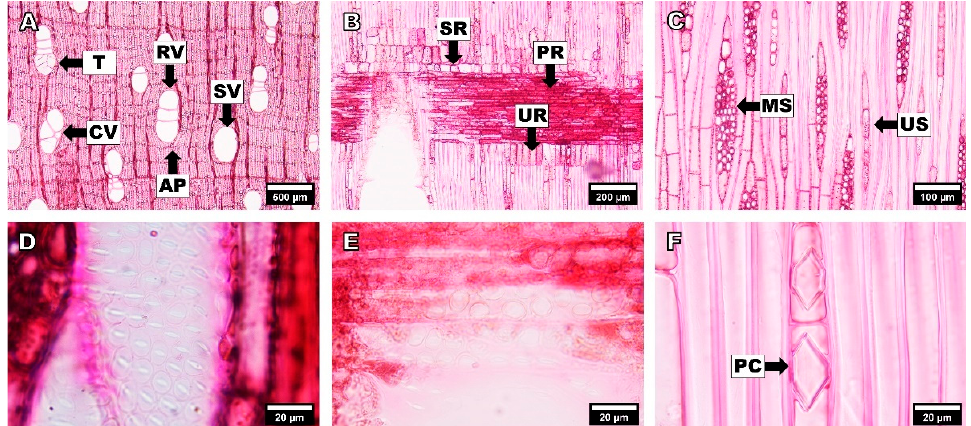
Figure 5. Optical micrographs of Hevea brasiliensis . Cross-section ( A ), radial section ( B ), tangential section ( C ), intervessel pits ( D ), vessel-ray pits ( E ), and mineral inclusions ( F ). Solitary vessel (SV), radial vessel (RV), cluster vessel (CV), axial parenchyma (AP), tyloses (T), procumbent body ray (PR), square body ray (SR), upright body ray (UR), uniseriate ray (US), multiseriate ray (MS), and prismatic crystal (PC).